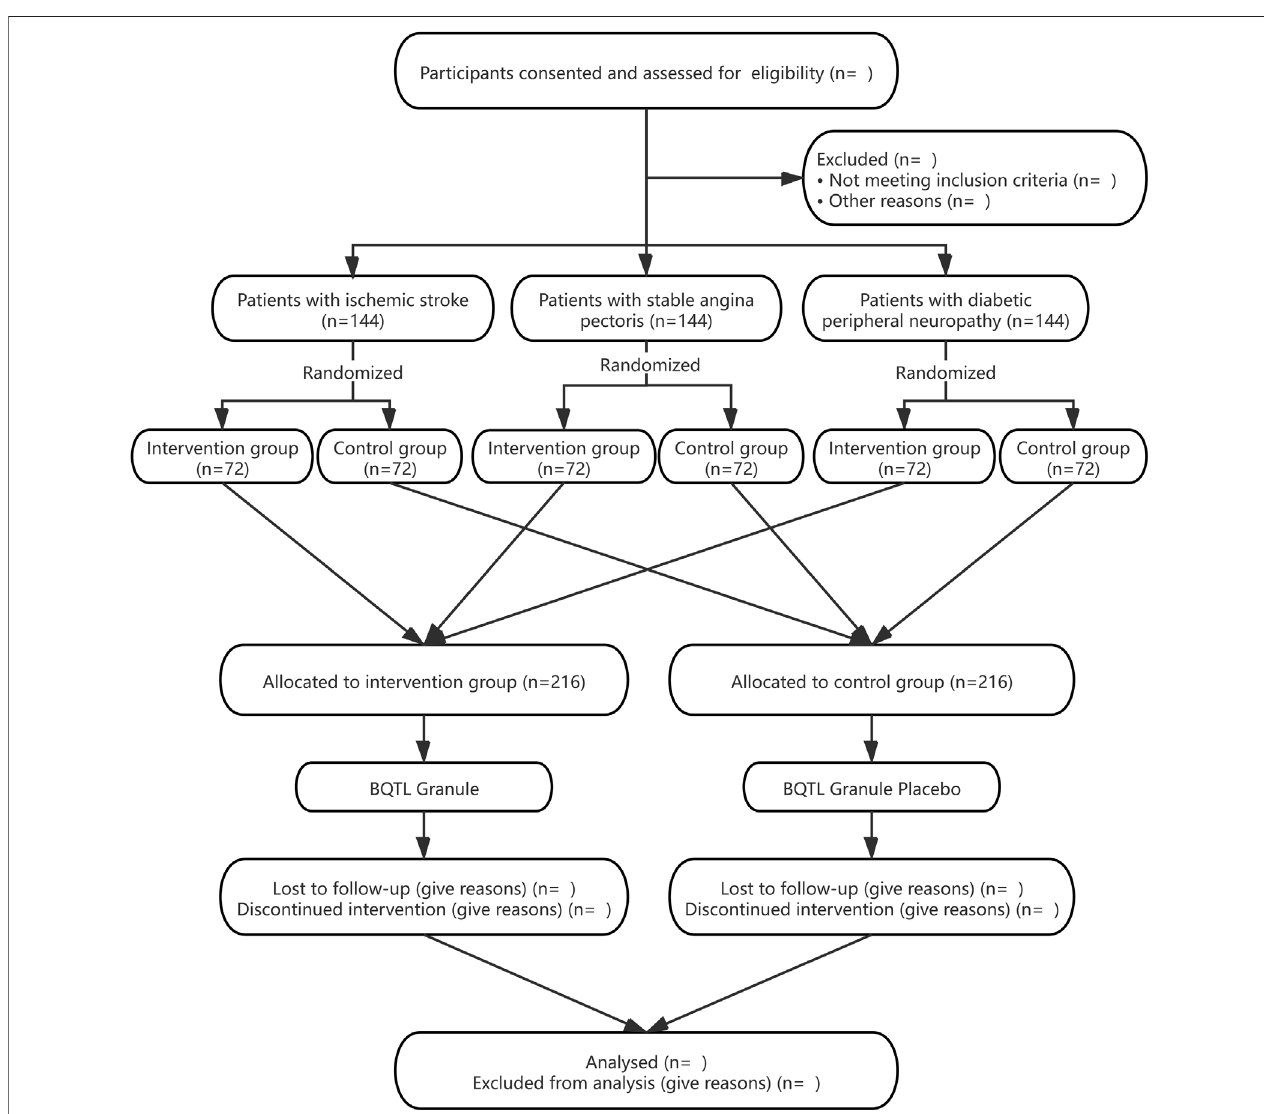
FIGURE 1 | The fl owchart of participants disposition throughout the